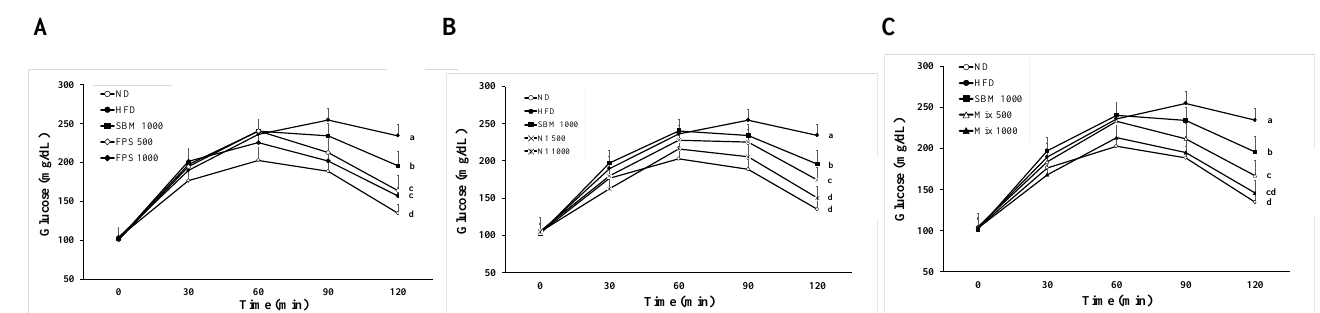
Figure 2. The concentration of plasma glucose in rats fed various fermented SBM products during the oral glucose tolerance test (OGTT). The rats were fed a HFD for 10 weeks, followed by various fermented SBM products for 6 weeks, as described in Materials and Methods. The blood samples were individually collected at the scheduled time points from rats fed SBM or products fermented with ( A ) Lactobacillus sp. FPS 2520 (FPS), ( B ) Bacillus sp. N1 (N1), or ( C ) mixed strains (Mix), after glucose treatment. Results are expressed as a mean ± standard deviation for each group of rats ( n = 8). Different letters (a – d) indicate the statistical difference ( p < 0.05) between each group.